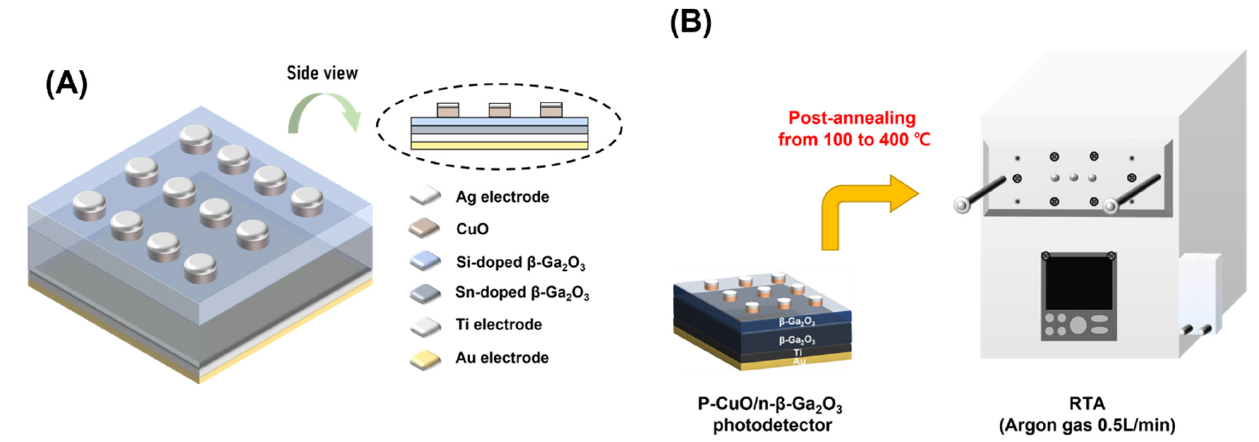
Figure 1. ( A ) Illustration of as-fabricated CuO/ β -Ga 2 O 3 -based heterojunction photodetectors with Ag electrode; ( B ) photodetector postannealing process in RTA.